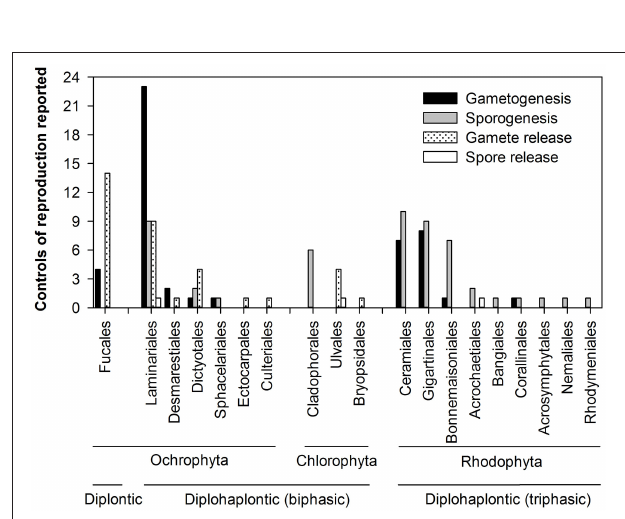
FIGURE 2 | Distribution of reproductive events (gametogenesis, sporogenesis, gamete release, and spore release) controlled by environmental/endogenous factors reported in this review ( N = 136 reproductive events) within seaweed order, phylum, and life